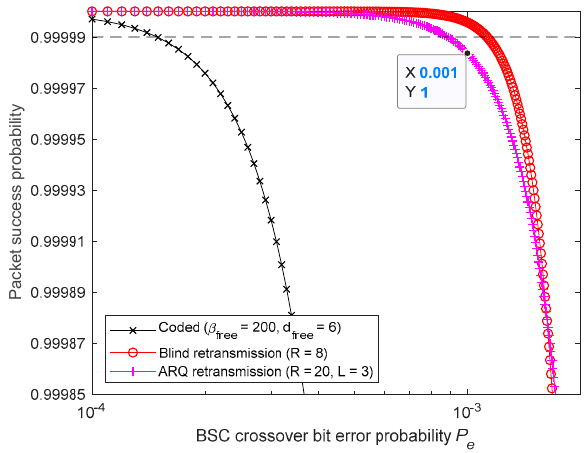
Figure 25. Meeting 99.999% reliability target by using BR and 4 -Rep-ACK retransmissions.